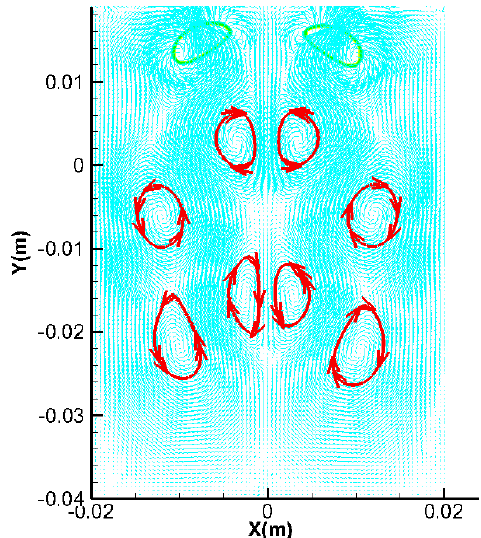
Figure 16. The vortex generated by a rising bubble.